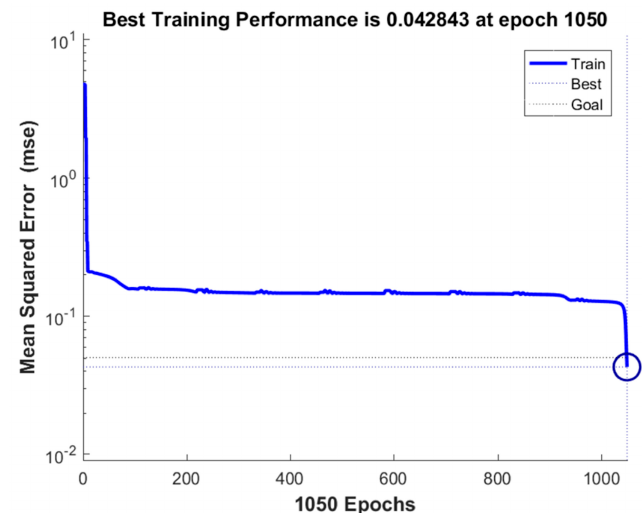
Figure 15. Error convergence curve in the training process of BP neural network.